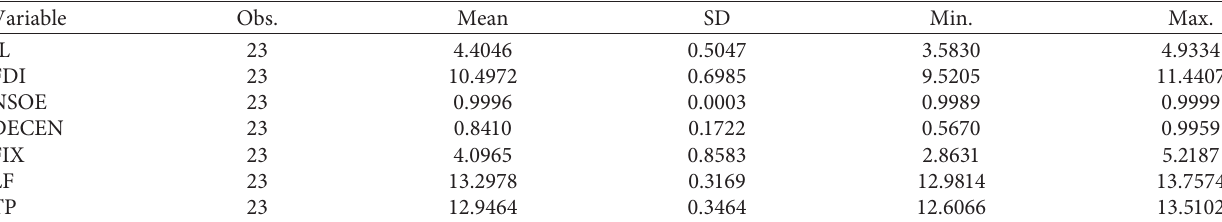
Figure 6: Spatial changes of the industrial land in Shunde from 1995 to 2017. Table 3: Descriptive statistics of analysis